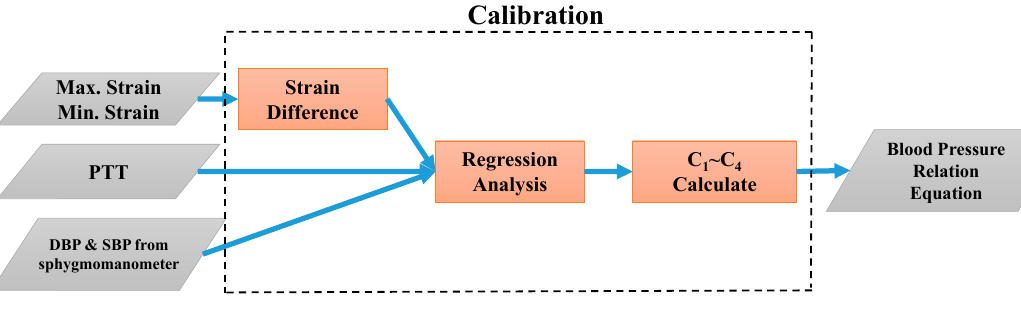
Figure 9. Flowchart of program calibration via LabVIEW.